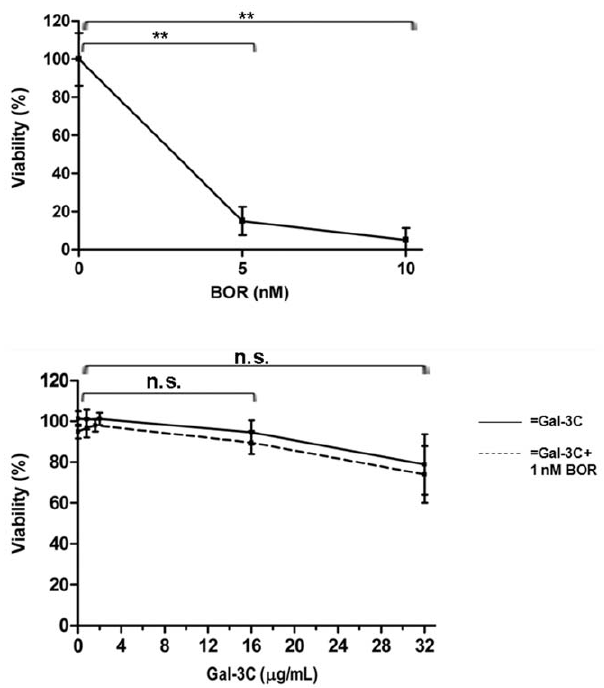
Figure 4. Vascular endothelial cell viability assay. Viability was measured as described for U266 cells in experiments run in triplicate and displayed as percentage of control (untreated) cells. The graphs show mean values and error bars represent 6 SD. **ANOVA Tukey’s post test P , 0.01. n.s.=not significant. doi:10.1371/journal.pone.0021811.g004 The levels of VEGF and bFGF were extrapolated using standard curves obtained by analysis of 10-fold serial dilutions (0- 1,000 ng/mL) of the purified recombinant proteins (Abcam,